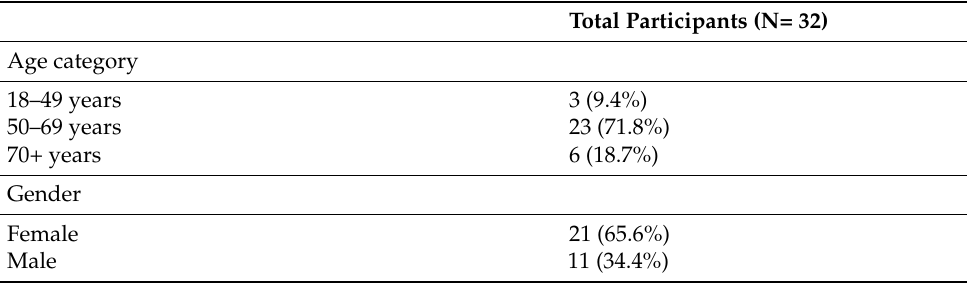
Table 3. Demographic details of participants included in the